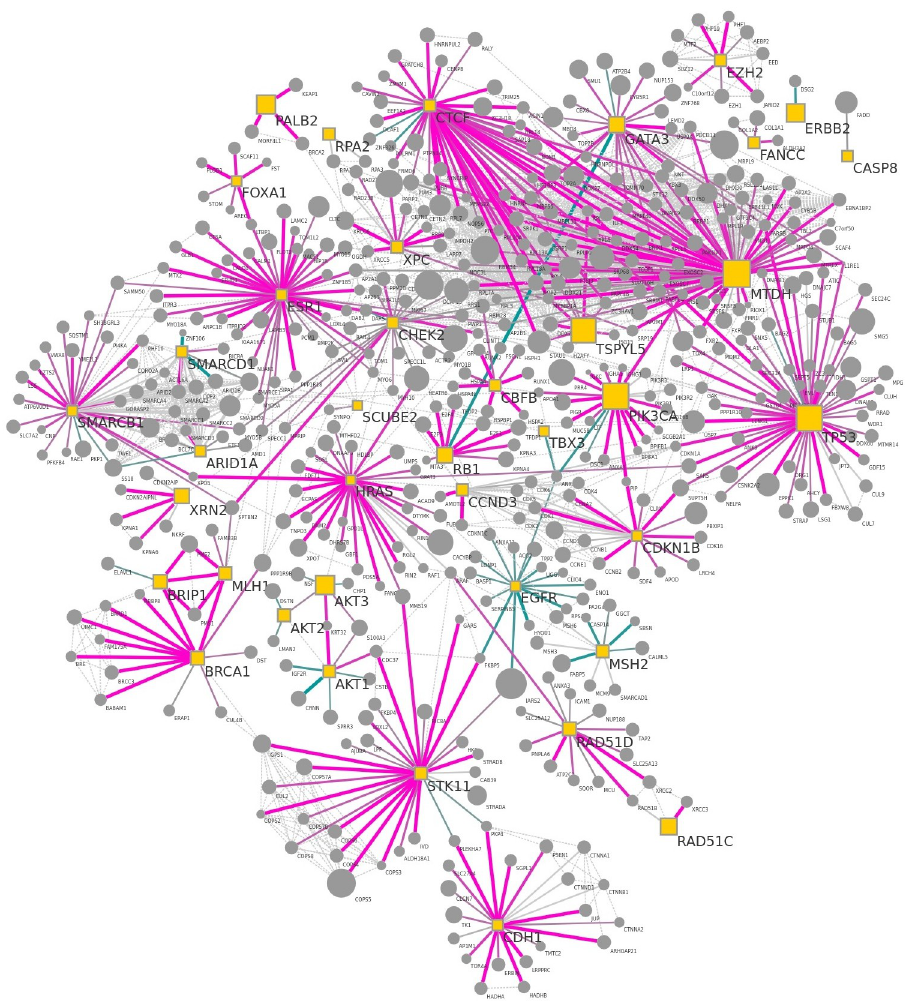
MCF10A. This network is available on NDEx by the UUID: